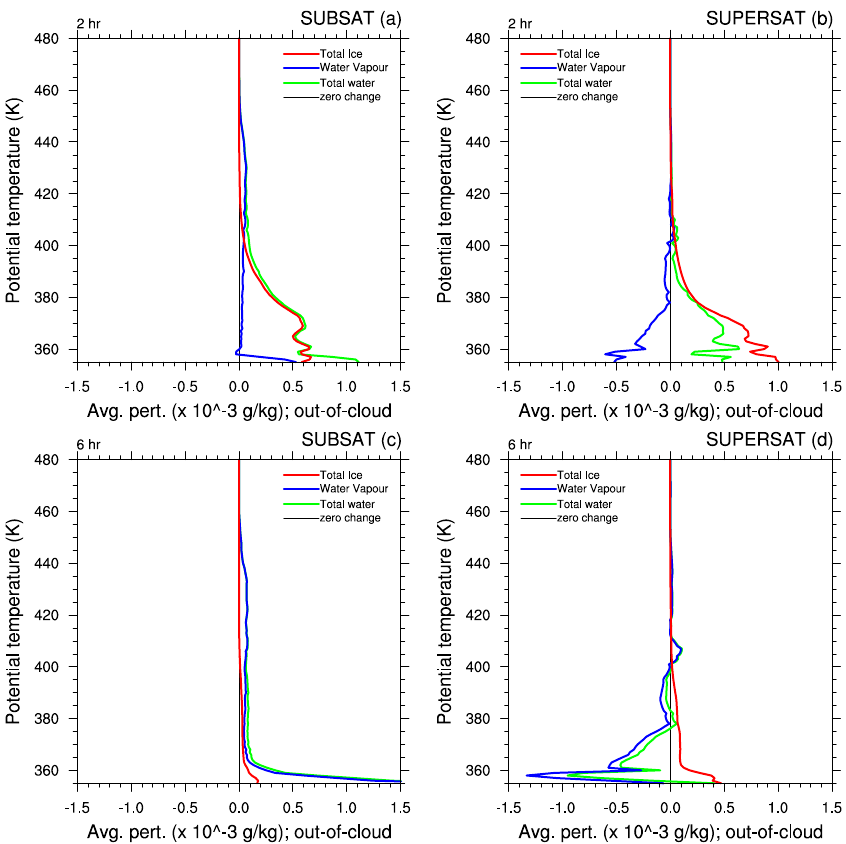
Figure 8: Average out-of-cloud perturbations in total water (green), total ice (red) and water vapour (blue) content, plotted against θ levels 355–480 K for each case at (a, b) 2 h and (c, d) 6 h.